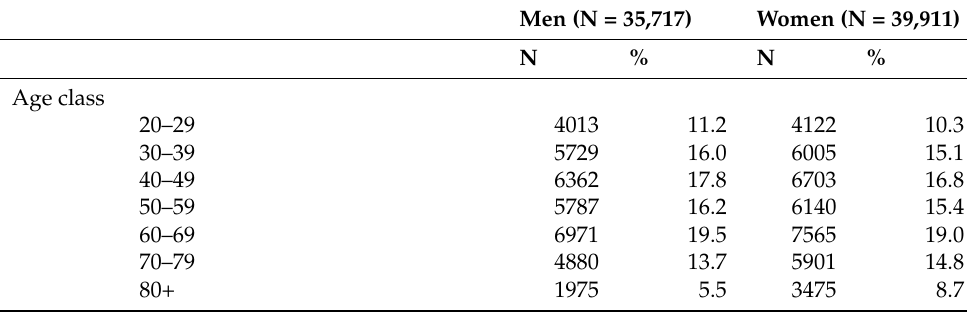
Table 1. Demographic Characteristics of Analyzed